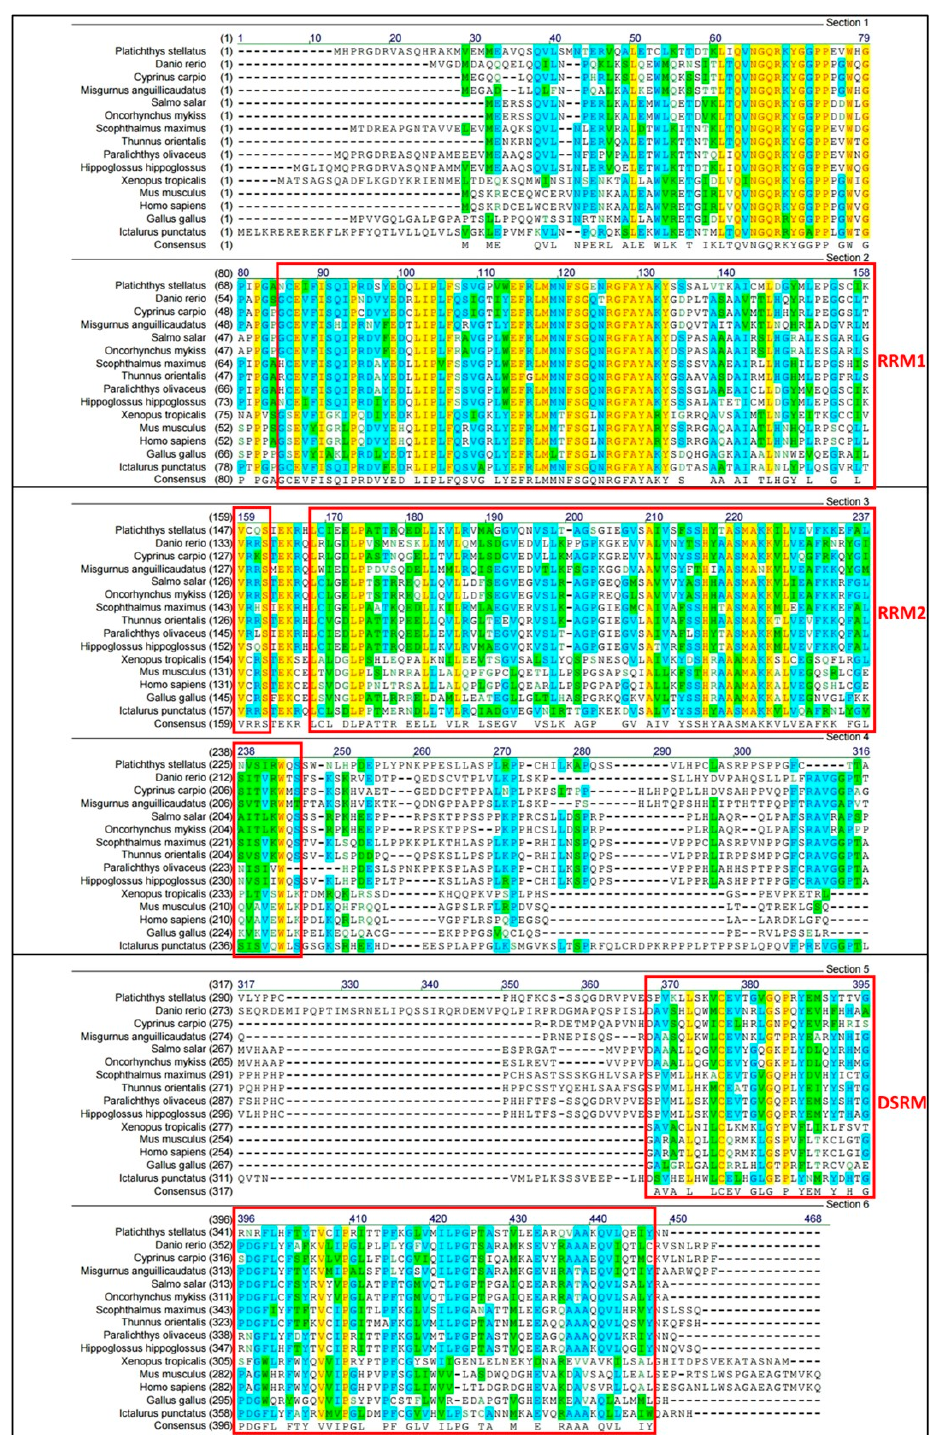
Figure 3. Multiple alignments of psdnd with dnd homologues from various vertebrate species. Black text on white: non-similar residues. Blue text on cyan: consensus residue, derived from a block of similar residues at a specific position. Black text on green: consensus residue, derived from an occurrence of ≥ 50% of a single residue at a specific position. Red on yellow: consensus residue, derived from a completely conserved residue at a specific position. Green text on white: residue similar to consensus residue at a specific position. Red boxes indicate conserved motifs including RRM1, RRM2 and, DSRM. Multiple alignment analyzed by align X program. Conserved domain was analyzed at NCBI conserved domain site.